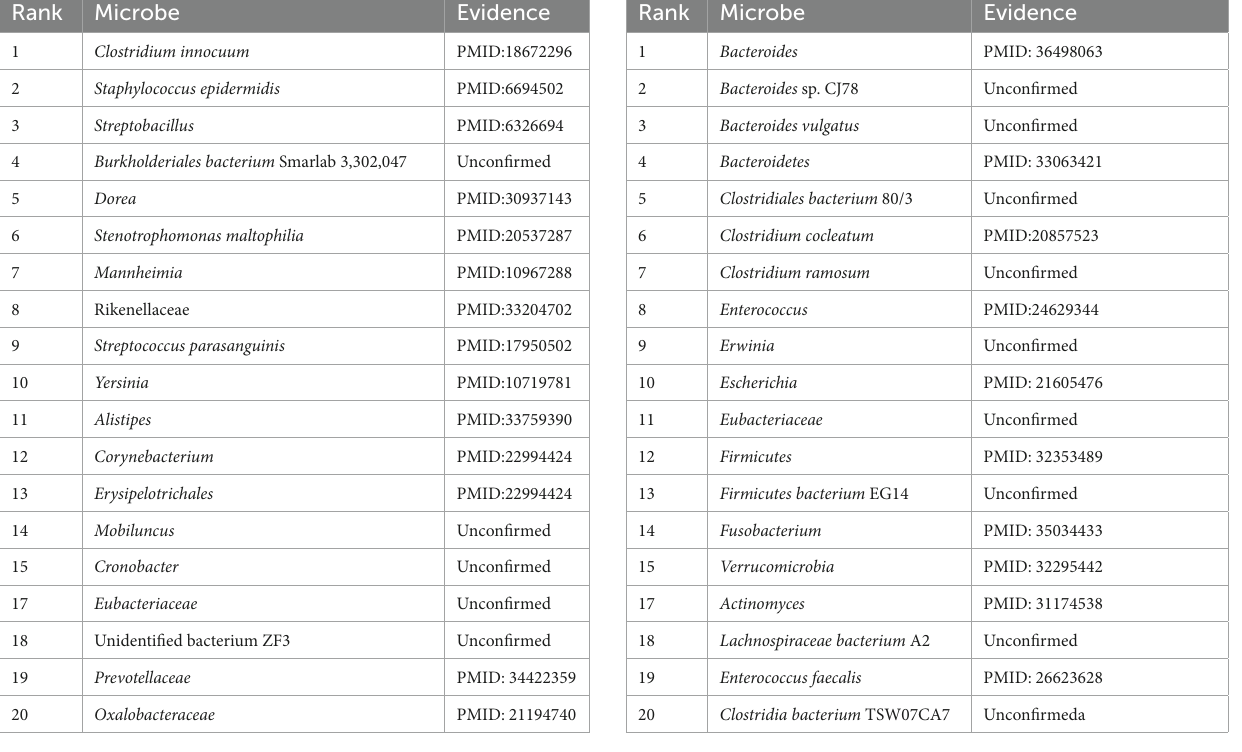
TABLE 3 The top 20 asthma-associated microbes predicted by MADGAN. Rank Microbe